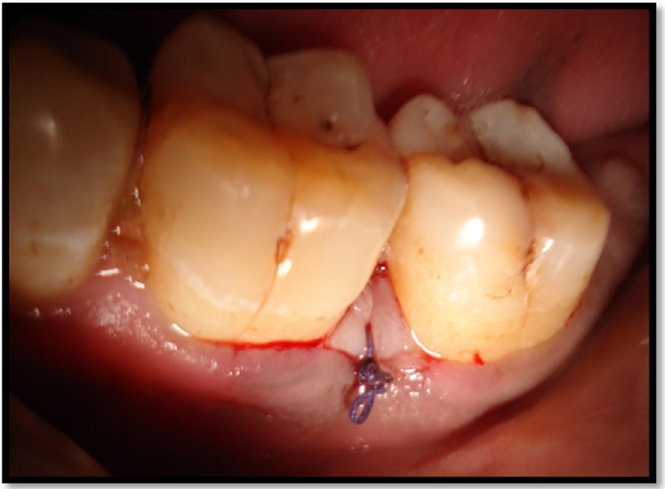
Figure 4. vertical internal mattress sutures placed for flap